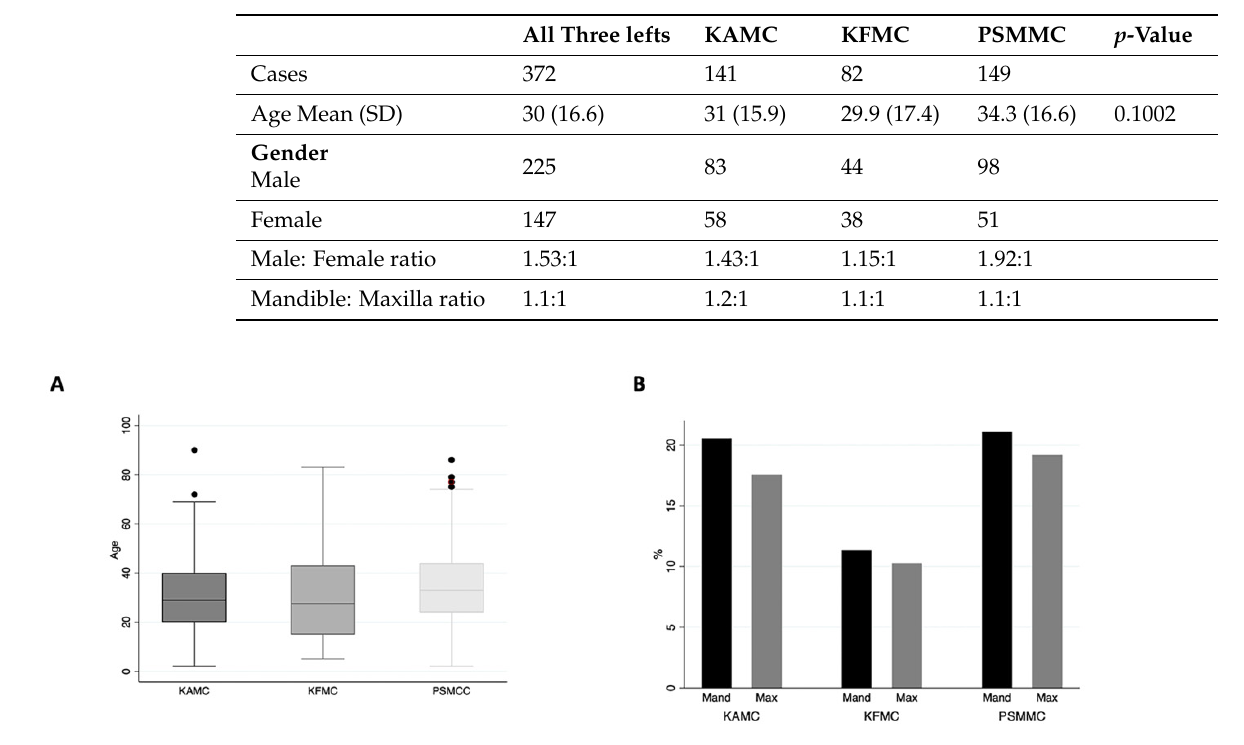
Figure 3. ( A ) The mean age of OCs at each center is relatively similar, with a p -value of 0.1. ( B ) Location distribution of OCs at each center.